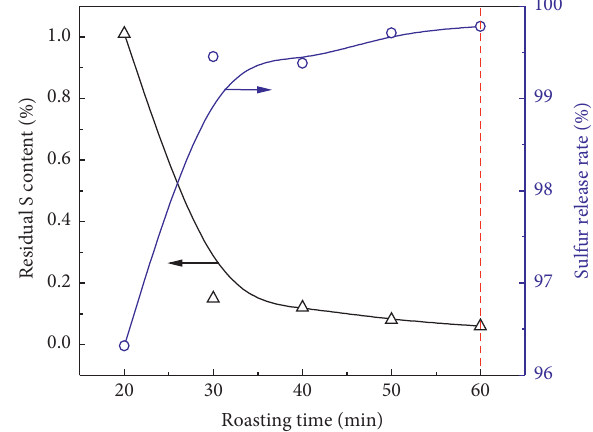
Figure 9: Effect of residence time on sulfur release rate and residual S content (conditions: roasting temperature � 1200 ° C and air flow � 1.0L/min).